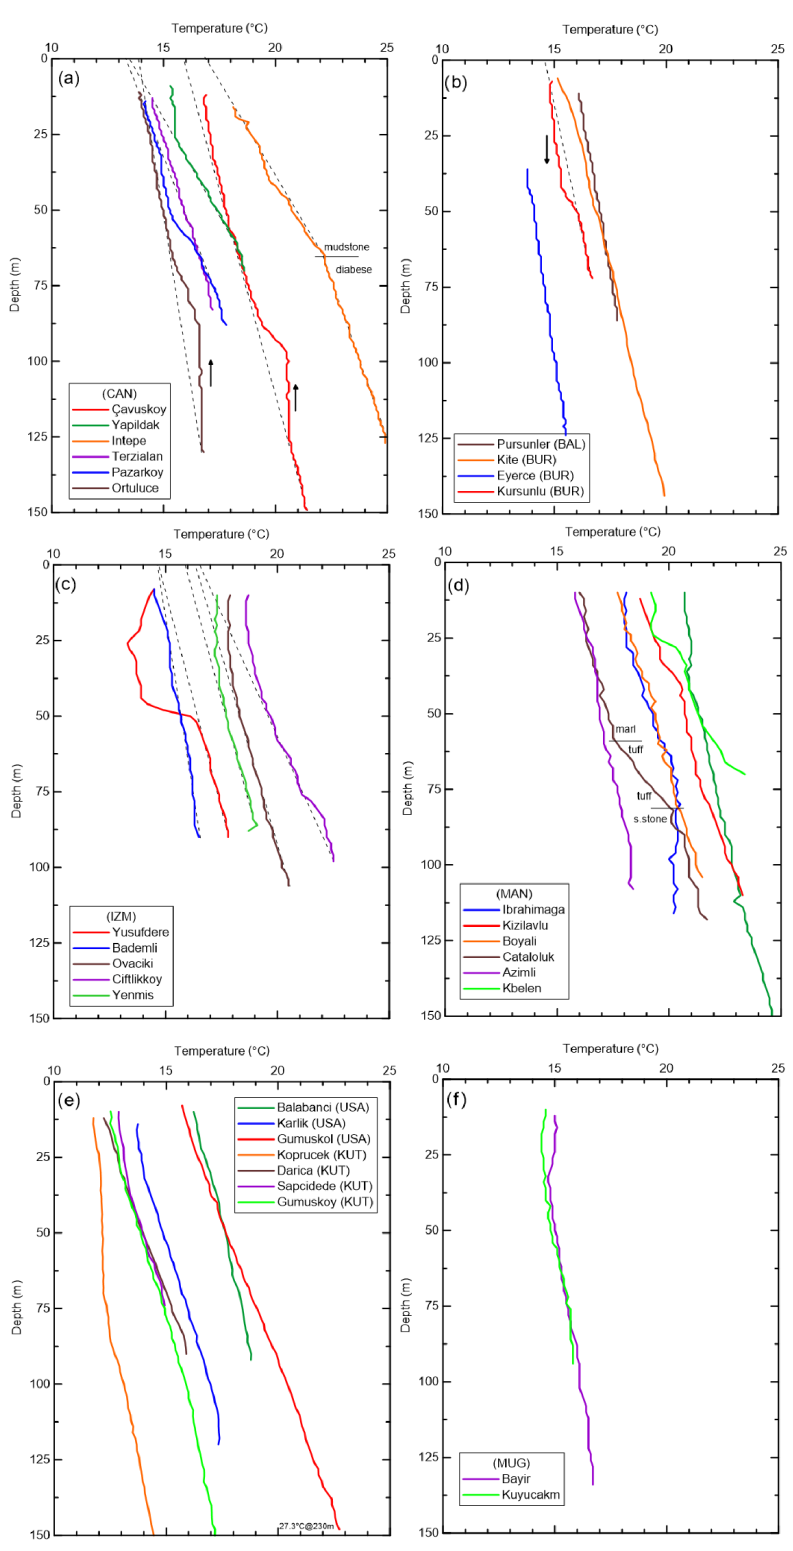
Figure 2. Temperature–depth ( T – D ) curves for classes A/B/C data for the provinces of (a) Çanakkale, (b) Balıkesir/Bursa, (c) Izmir, (d) Manisa, (e) U¸sak/Kütahya, and (f) Mu˘gla. Vertical arrows show the inferred direction of intra-borehole fluid flow.